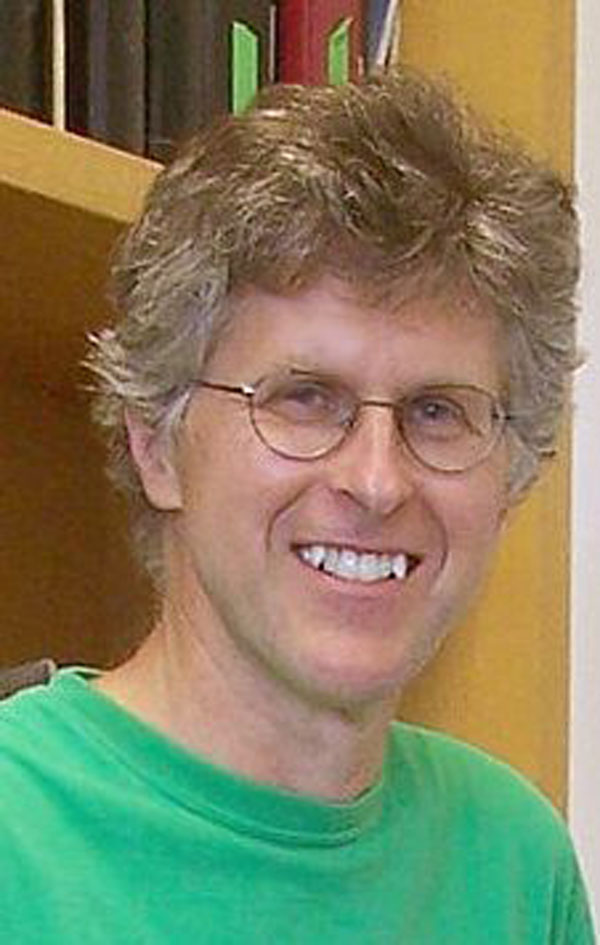
Patrick O Brown.